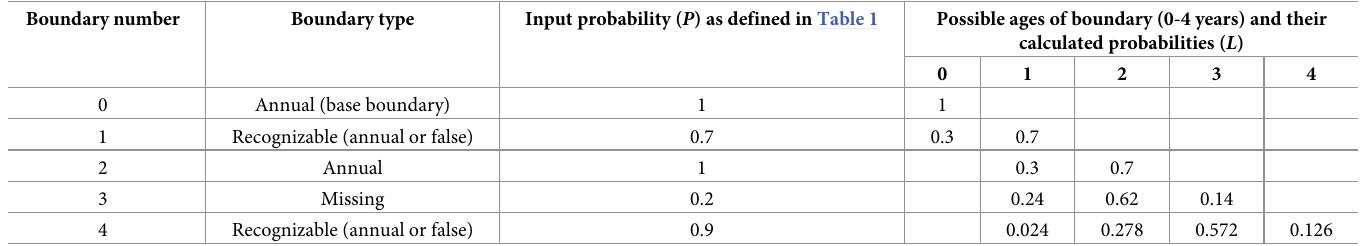
Table 2. Hypothetical input data and assignation of possible ages with probabilities for five boundaries. Boundary